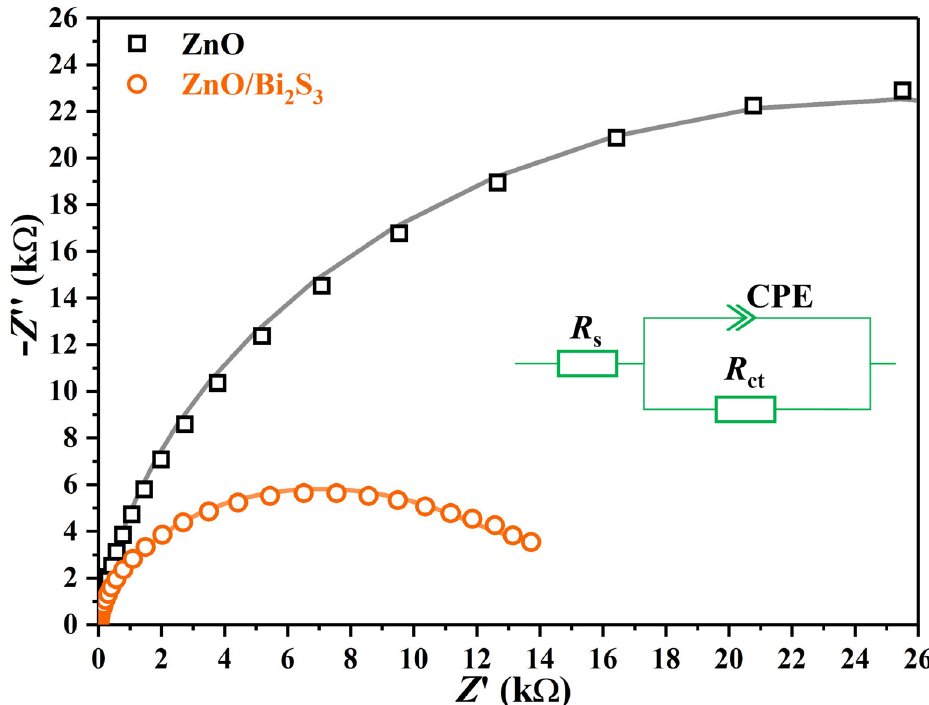
Figure 9. EIS Nyquist plots of ZnO and ZnO/Bi 2 S 3 photoanodes under dark. The small circles and squares in the plots represent the experimental data, and the solid lines represent the fitting results. The inset is the proposed equivalent circuit model, in which R s is the solution resistance; CPE is the capacitance phase element for the semiconductor/electrolyte interface; and R ct is the charge transfer resistance across the interface.